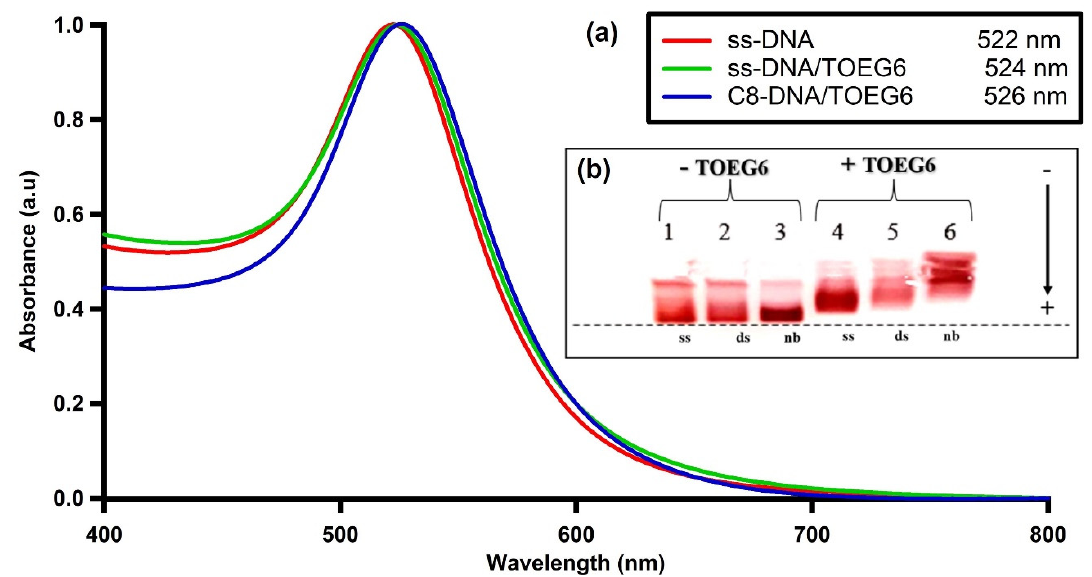
Figure 5. ( a ) The UV-Vis absorption spectra of VHH-terminated DNA/TOEG6@AuNPs at each step of the NP functionalization. ( b ) Gel electrophoresis of AuNPs functionalized with: ( 1 ) ss-DNA; ( 2 ) ds-DNA; ( 3 ) ss-DNA + cDNA-C8 conjugates; ( 4 ) ss-DNA/TOEG6; ( 5 ) ds-DNA/TOEG6; ( 6 ) ds-DNA/TOEG6 cDNA-C8 conjugates. The arrow indicates the migration direction.